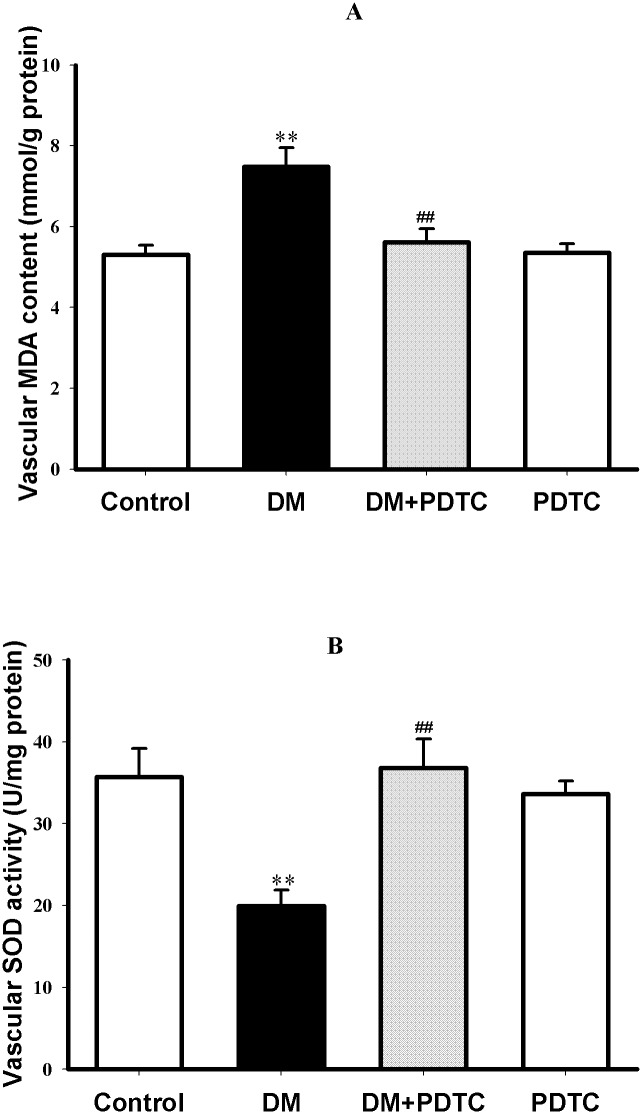
PDTC treatment alleviated oxidative stress in aortas of diabetic rats.Oxidative stress was reflected by the increased content of the lipid peroxidation product malondialdehyde (MDA, Fig 4A) and the decreased activity of antioxidant enzyme superoxide dismutase (SOD, Fig 4B) in aortic tissue of rats. Data are expressed as mean ± SEM. n = 6. **P<0.01 vs Control. ##P<0.01 vs DM.